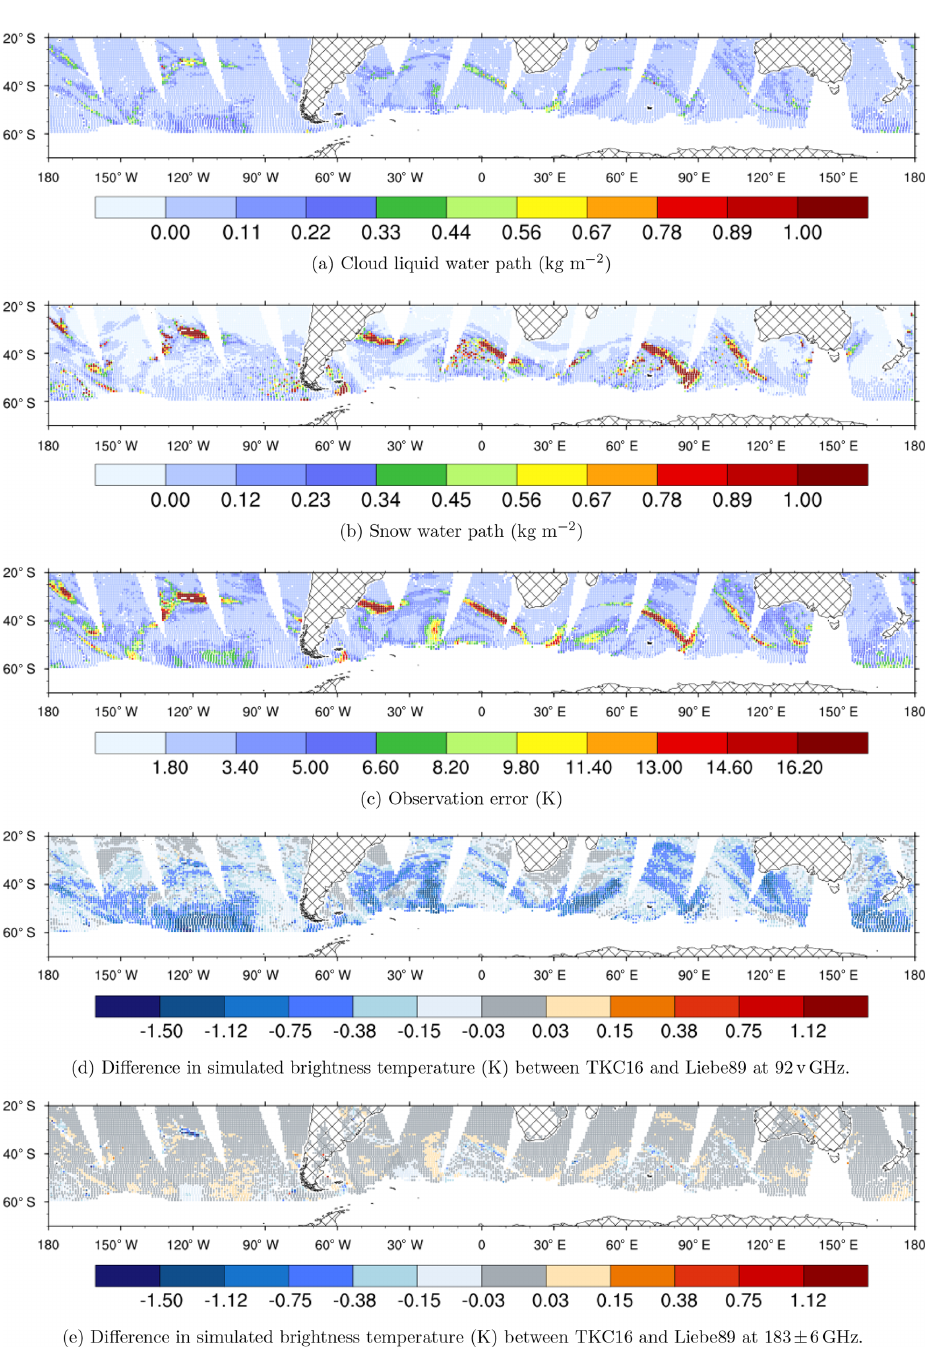
Figure 7. Maps for (a) cloud liquid water path from the corresponding FG field, (b) snow water path from the corresponding FG field, (c) observation error with Liebe89, (d) difference in FG at 92v between TKC16 and Liebe89 and (e) difference in FG at 183 ± 6GHz between TKC16 and Liebe89 for areas of the southern midlatitudes to high latitudes excluding land and sea ice for a 12h window centred at 03:00UTC on 30 August 2016, co-located to SSMIS-F17 observations. Cross-hatched areas represent land and white areas have no data, e.g. due to screening or quality control (see Sect.